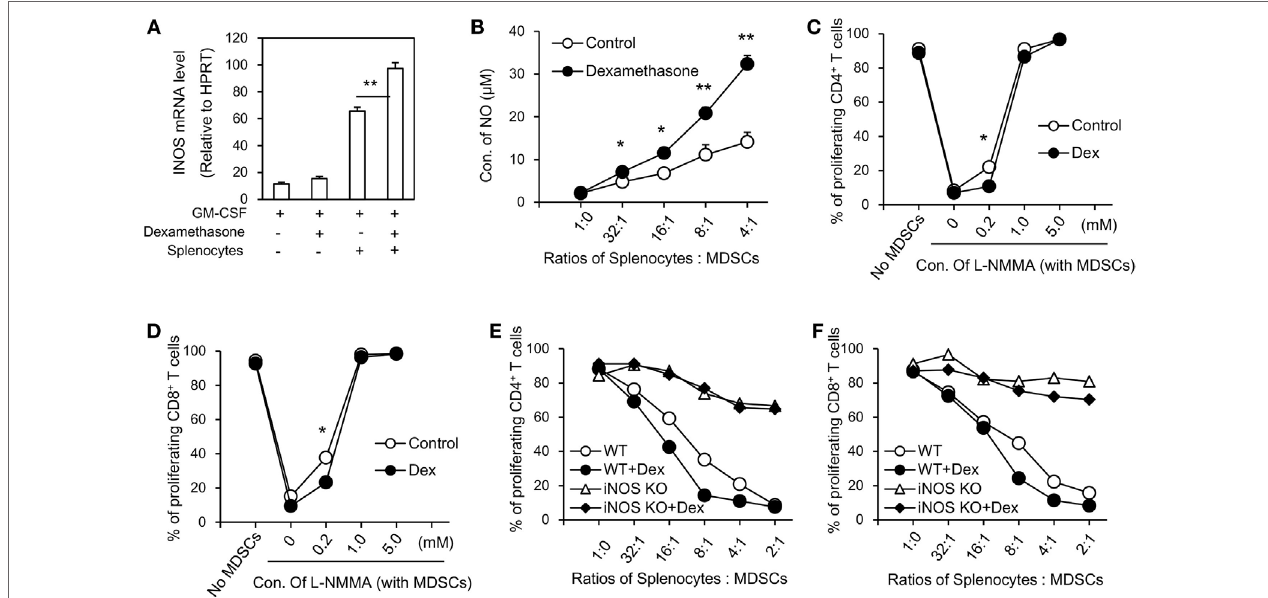
FigUre 2 | Dexamethasone (Dex) enhances the inhibitory function of myeloid-derived suppressor cells (MDSCs) through iNOS pathway. (a) MDSCs (C57BL/6, CD45.1) induced by granulocyte macrophage colony stimulating factor (GM-CSF) or GM-CSF + Dex were cocultured with splenic cells (C57BL/6, CD45.2) in the presence of conA (2 µg/ml) at a ratio of 1:1 for 3 days, and MDSCs were harvested by flow cytometry based on the surface staining of CD45.1. The mRNA expression of iNOS in harvested MDSCs was determined by RT-PCR. (B) MDSCs induced in vitro were cocultured with CFSE-labeled splenic cells (2 × 10 5 per well) stimulated by ConA (2 µg/ml) at different ratios for 72 h and the NO levels in the coculture medium were assessed. iNOS inhibitor L-NMMA at different concentrations were added into T cells and MDSCs coculture system for 72 h. Percentage of proliferating CD4 + T cells (c) and CD8 + T cells (D) were shown. MDSCs induced from iNOS knockout (KO) mice by GM-CSF or GM-CSF + Dex were added to CFSE-labeled splenic cell proliferation assay. iNOS deficiency significantly reversed the inhibitory effect of MDSCs induced by GM-CSF + Dex on CD4 + T cells (e) and CD8 + T cells (F) . Data are shown as Mean ± SEM. All the data are composite of three independent experiments (* P < 0.05, ** P <